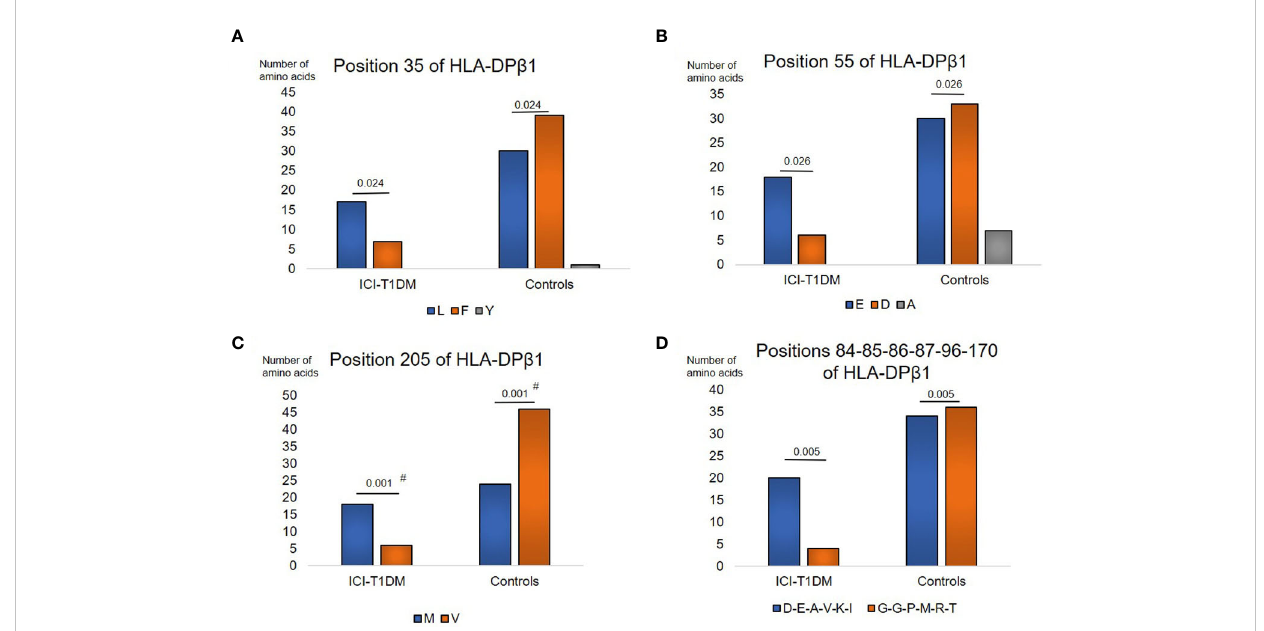
FIGURE 3 Then, prevalence of amino acid carriages at residues of HLA-DPB1 allele in patients with ICI-T1DM and ICI-controls (A – D) . Prevalence of amino acid at position 35, L, Leucine vs F, Phenylalanine, P=0.024. OR 3.16, 95%CI: 1.16-8.59 (A) , position 55, E, Glutamic acid vs D, Aspartic acid, P=0.026. OR 3.3, 95%CI: 1.16-9.41 (B) , position 205, M, Methionine vs V, Valine, P=0.001. OR 5.75, 95%CI: 2.02-16.39 (C) , and positions 84-85-86-87-96-170, D- E-A-V-K-I, Aspartic acid-Glutamic acid-Alanine-Valine-Lysine-Isoleucine vs G-G-P-M-R-T, Glycine-Glycine-Proline-Methionine-Arginine-